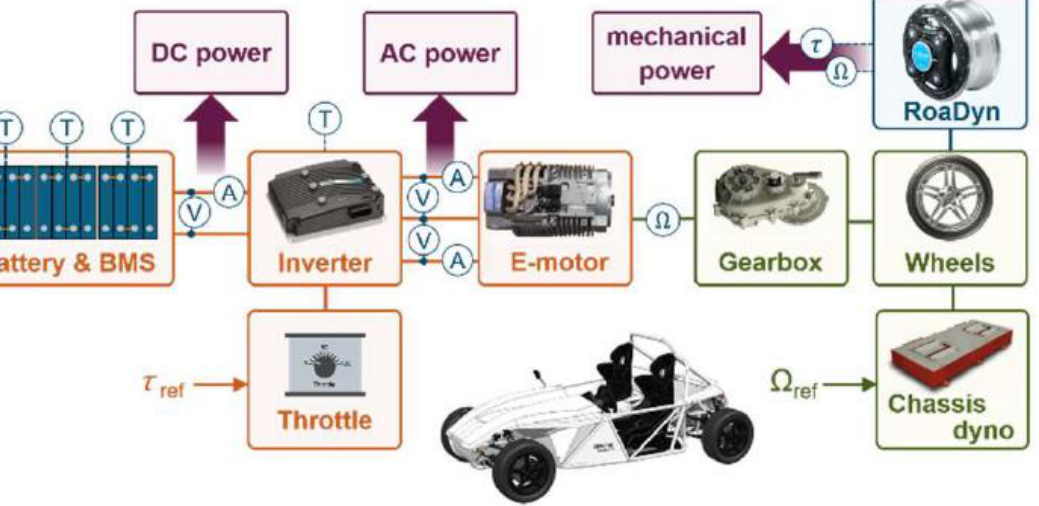
Figure 17. NEDC speed profile in RPM.